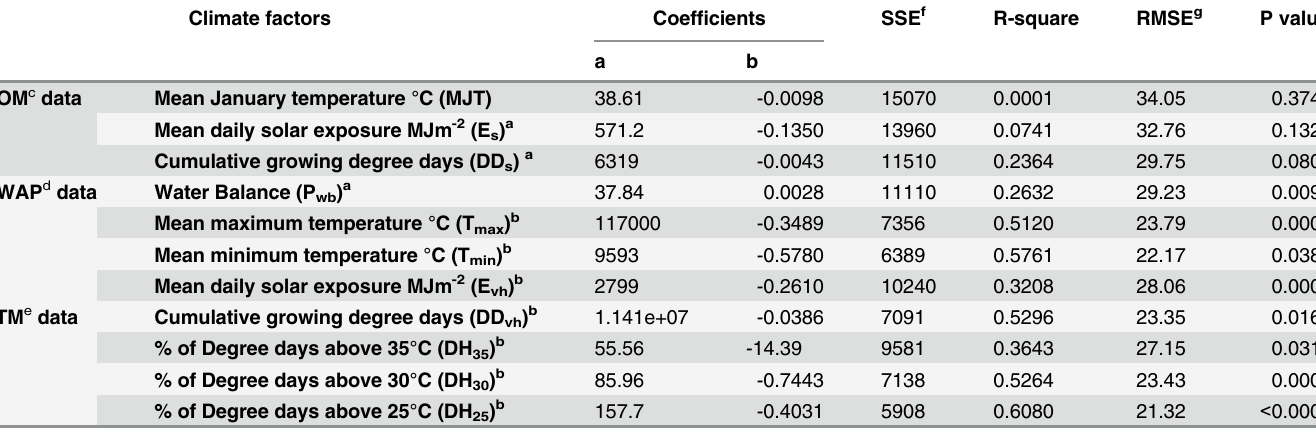
Table 1. Exponential relationships (y = a exp(bx)) between rotundone concentration in wine (Rot w ) and climatic parameters. Climate